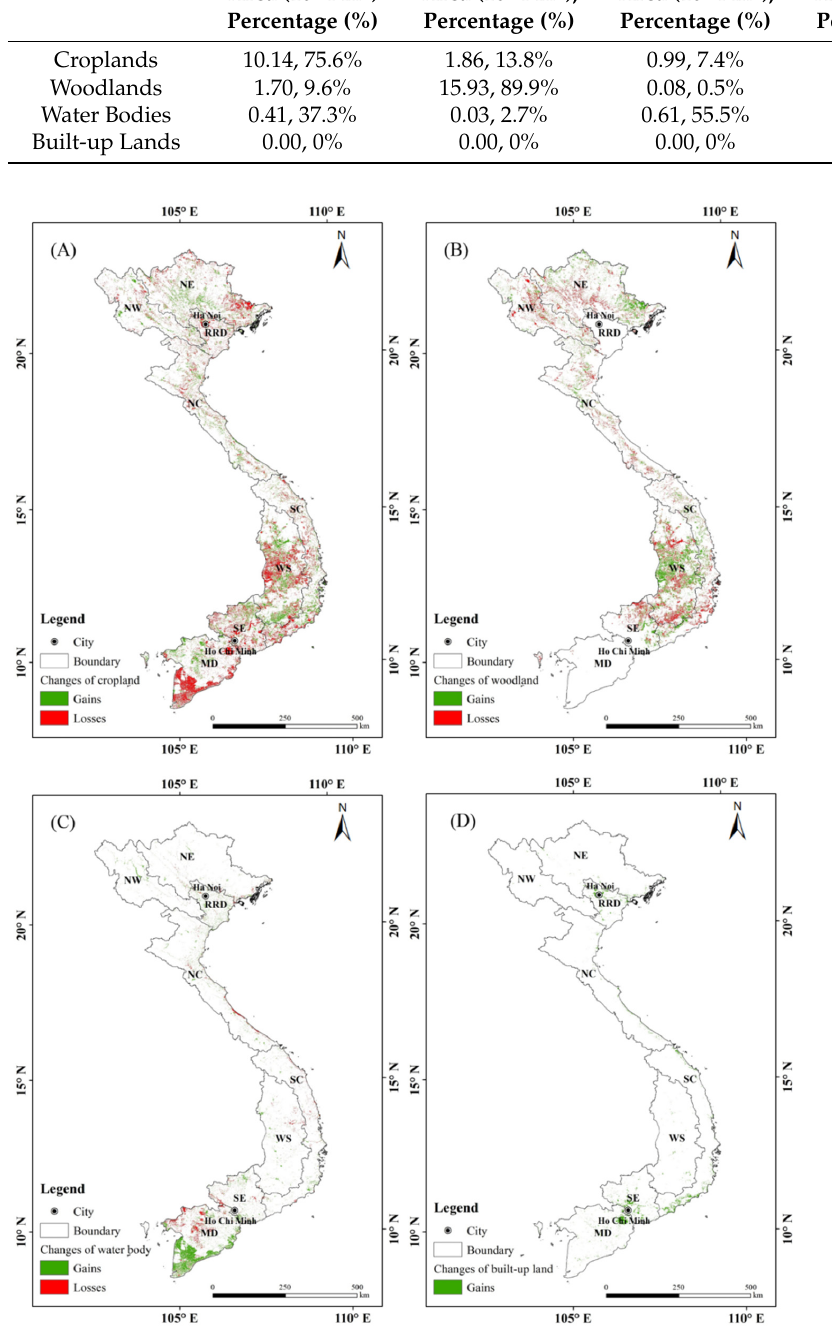
Figure 6. Spatial distributions of gains/losses of cropland ( A ), woodland ( B ), water body ( C ) and built-up land ( D ) during the period 2000–2020. Loss indicates that the land cover category was converted to other land cover categories, while gain shows that other land use types were transferred to the given land cover type from 2000 to 2020. Table 5. Land-use/land cover transfer matrix in Vietnam during the period 2000–2020.